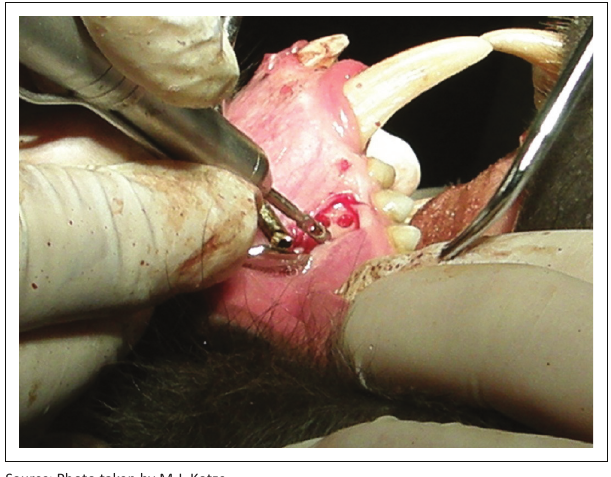
Source : Photo taken by M.J. Kotze FIGURE 1: Three bone defects were positioned at 2 mm from each other.